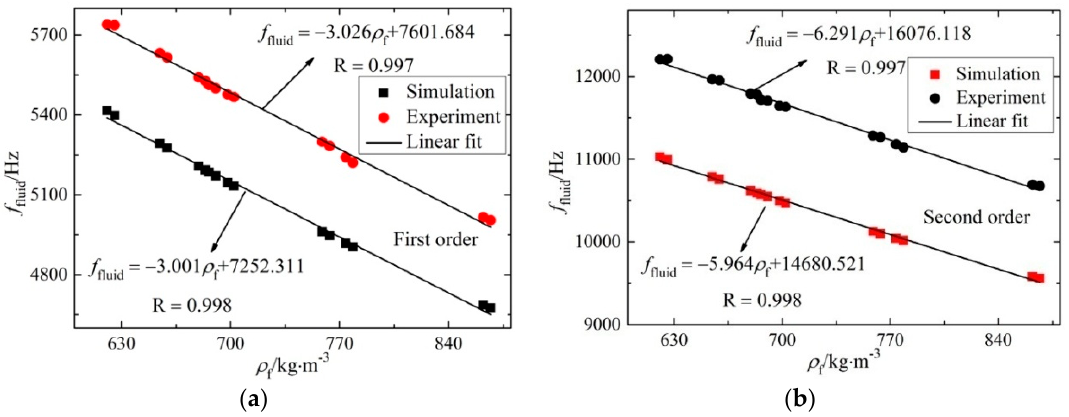
Figure 4. The relationship of resonant frequency and density under different order modes. ( a ) Under the first order mode (flexure); ( b ) under the second order mode (torsion).